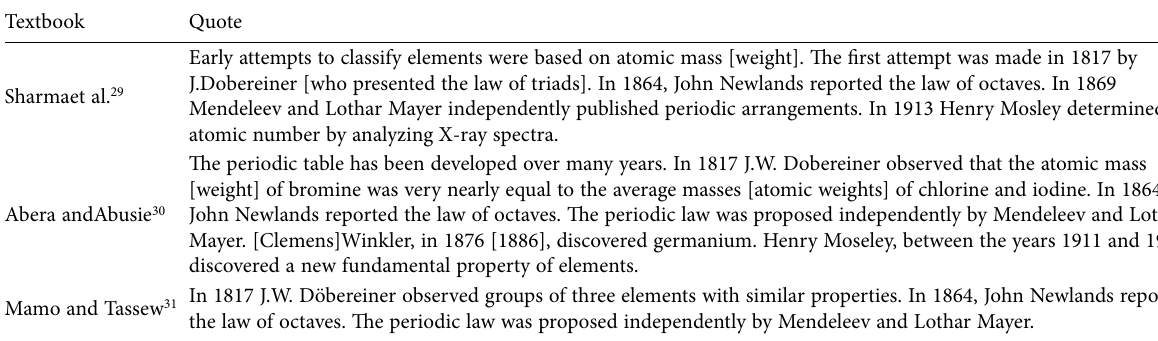
Table 1. Some quotations from the evaluated textbooks.